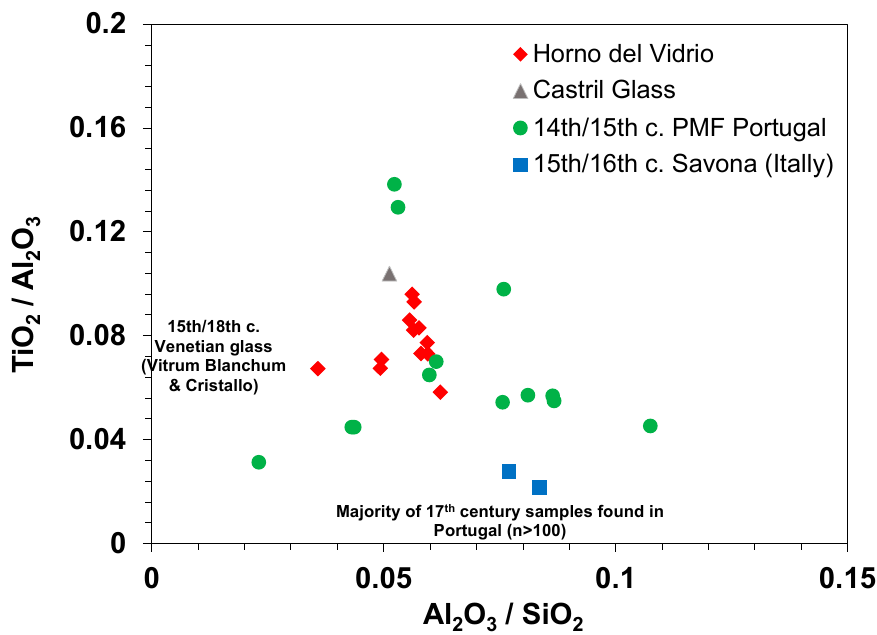
Figure 5. Binary plot of weight ratios of Al 2 O 3 /SiO 2 vs. the weight ratio of TiO 2 /Al 2 O 3 for the samples from the Horno del Vidrio together with the Castril glass, the 14th/15th century glass unearthed in Beja, Portugal (PMF) and the 15th/16th century glass from Savona, Italy [13,46,47].